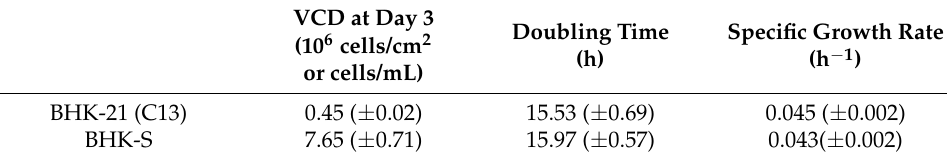
Table 1. Characteristic comparison between adherent BHK-21 (C13) and BHK-S.